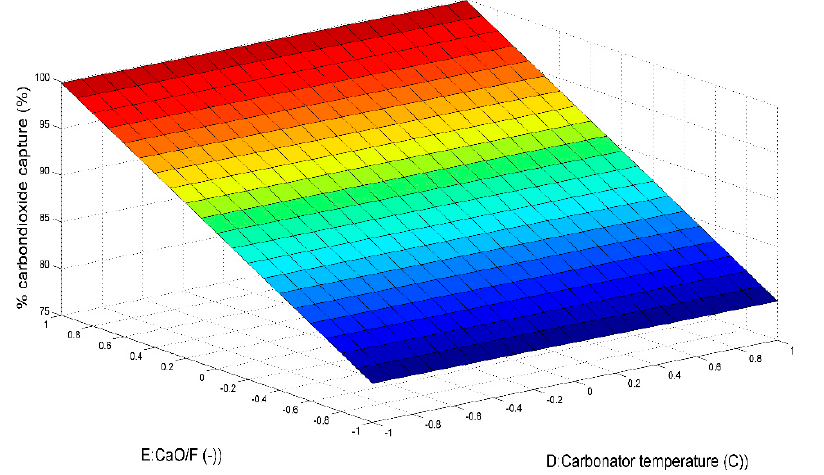
Figure 9. Response surface plot of %CO 2 capture in the calcium looping process as a function of the CaO/F mass ratio and carbonator temperature.